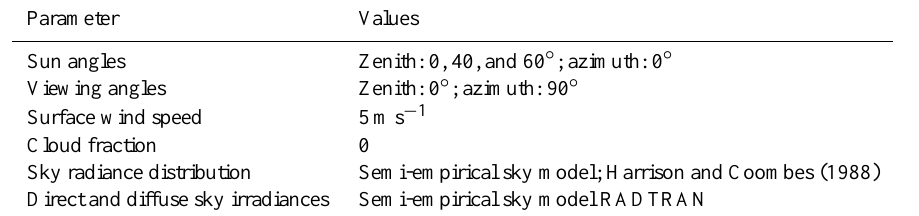
Table 10. Atmospheric, air–sea interface, and solar and viewing geometry specifications in